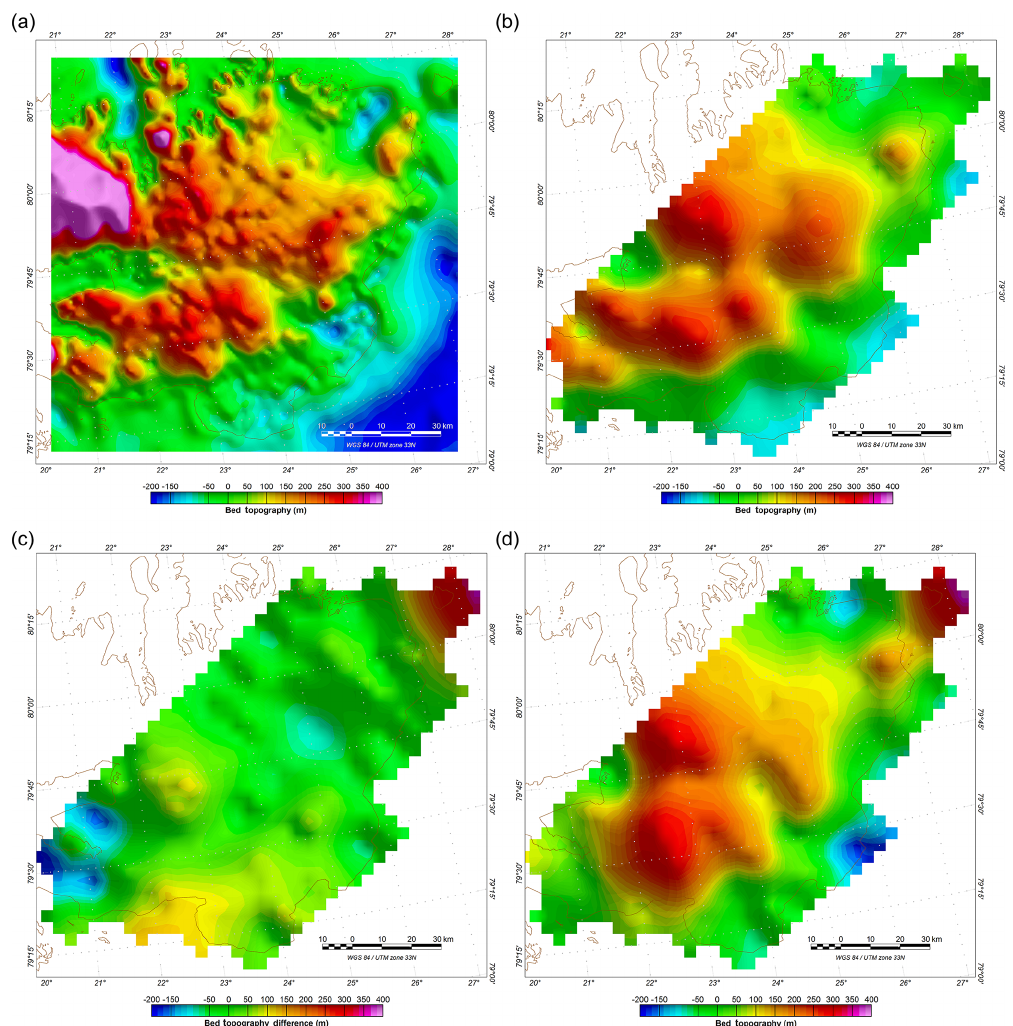
Figure 4. Bed topography derived from RES and GPR (a) , bed topography derived from RES and GPR gridded along gravity acquisition flight lines (b) , corrections applied to the bed topography (c) and bed topography corrected for gravity measurements gridded along gravity profiles (d) . Major discrepancies with deviations greater than 150m occur under Vegafonna (southwest) and Leighbreen and Worsleybreen